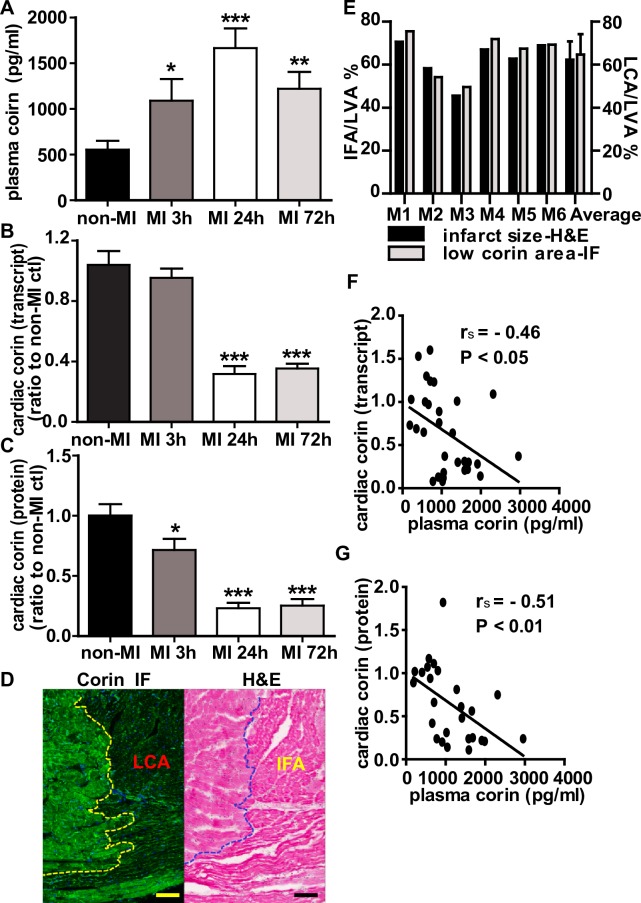
The changes in plasma and cardiac corin in early phase of AMI.(A) Plasma corin levels were measured by ELISA in non-MI group and at 3 h, 24 h and 72 h post-MI. (B) Corin cardiac transcript levels in infarct hearts assessed by qRT-PCR analysis in non-MI group and at the indicated time points post-MI. (C) Cardiac corin protein expression assessed by immunofluorescence (IF) staining with an anti-corin antibody. The total intensity of corin immuno-fluorescence (artificial units) and total myocardium area in each heart were measured in heart cross sections using Image-Pro Plus software, and the fluorescence intensity per myocardial area was calculated for each heart and expressed relative to average fluorescence intensity per myocardial area in control, non-MI mouse hearts. (D) Representative images of the same border zone on two serial heart sections of a MI heart from 24 h post-MI group, showing corin IF staining (left) and H&E staining (right) respectively. Scale bar = 100 μm. The lower corin expression area (LCA, or the area of decreased green fluorescence, left panel) in the heart was identical to the infarct area (IFA, eosinophilic staining area, right panel). The dotted line delineates the border of infarct area and non-infarct area in both images. (E) Relationship between the area of lower corin expression and the area of infarction in mice heart of 24 h post-MI. The LCA, IFA and total left ventricular area (LVA, including septum) were measured in cardiac sections by assessing corin immunofluorescence and H&E staining from hearts (n = 6) using Image-Pro Plus software. For each heart, the loss or LCA was measured and the LCA/LVA % calculated. On H&E stained sections, infarct area (eosinophilic staining area), total LVA and infarct size were measured, IFA/LVA % was calculated. (F & G) In non-MI and MI mice showed an inverse correlation between plasma corin levels and corin cardiac transcripts (arbitrary units) or protein levels. Data presented as mean ±SE of n = 7–9 mice per group. *P<0.05, **P<0.01, ***P<0.001 vs. non-MI control.